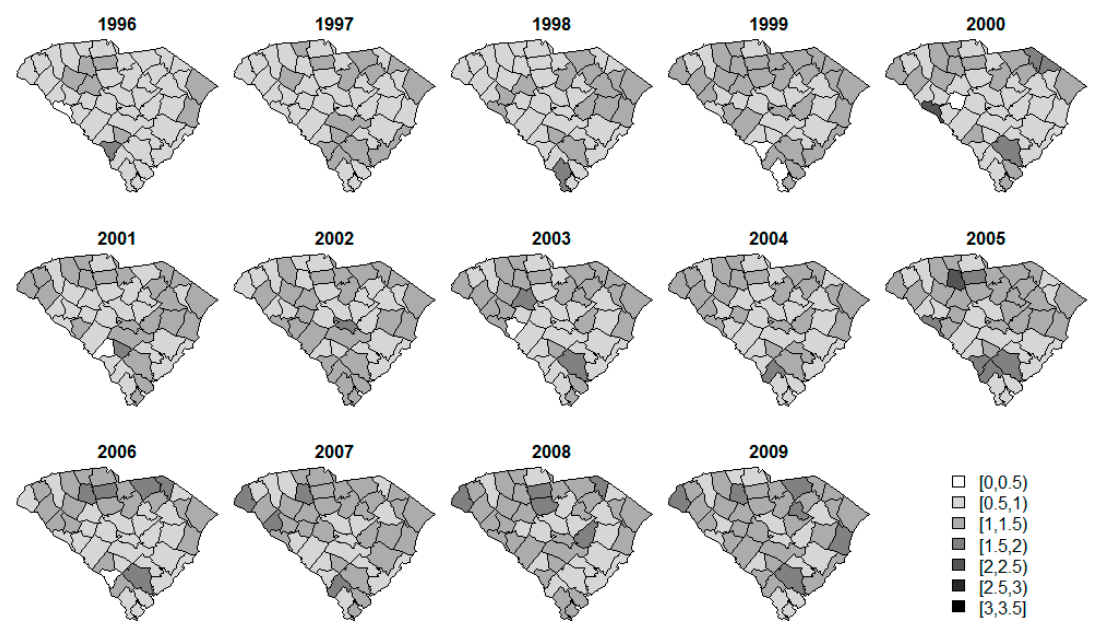
Figure 4. SIR of lung and bronchus cancer.